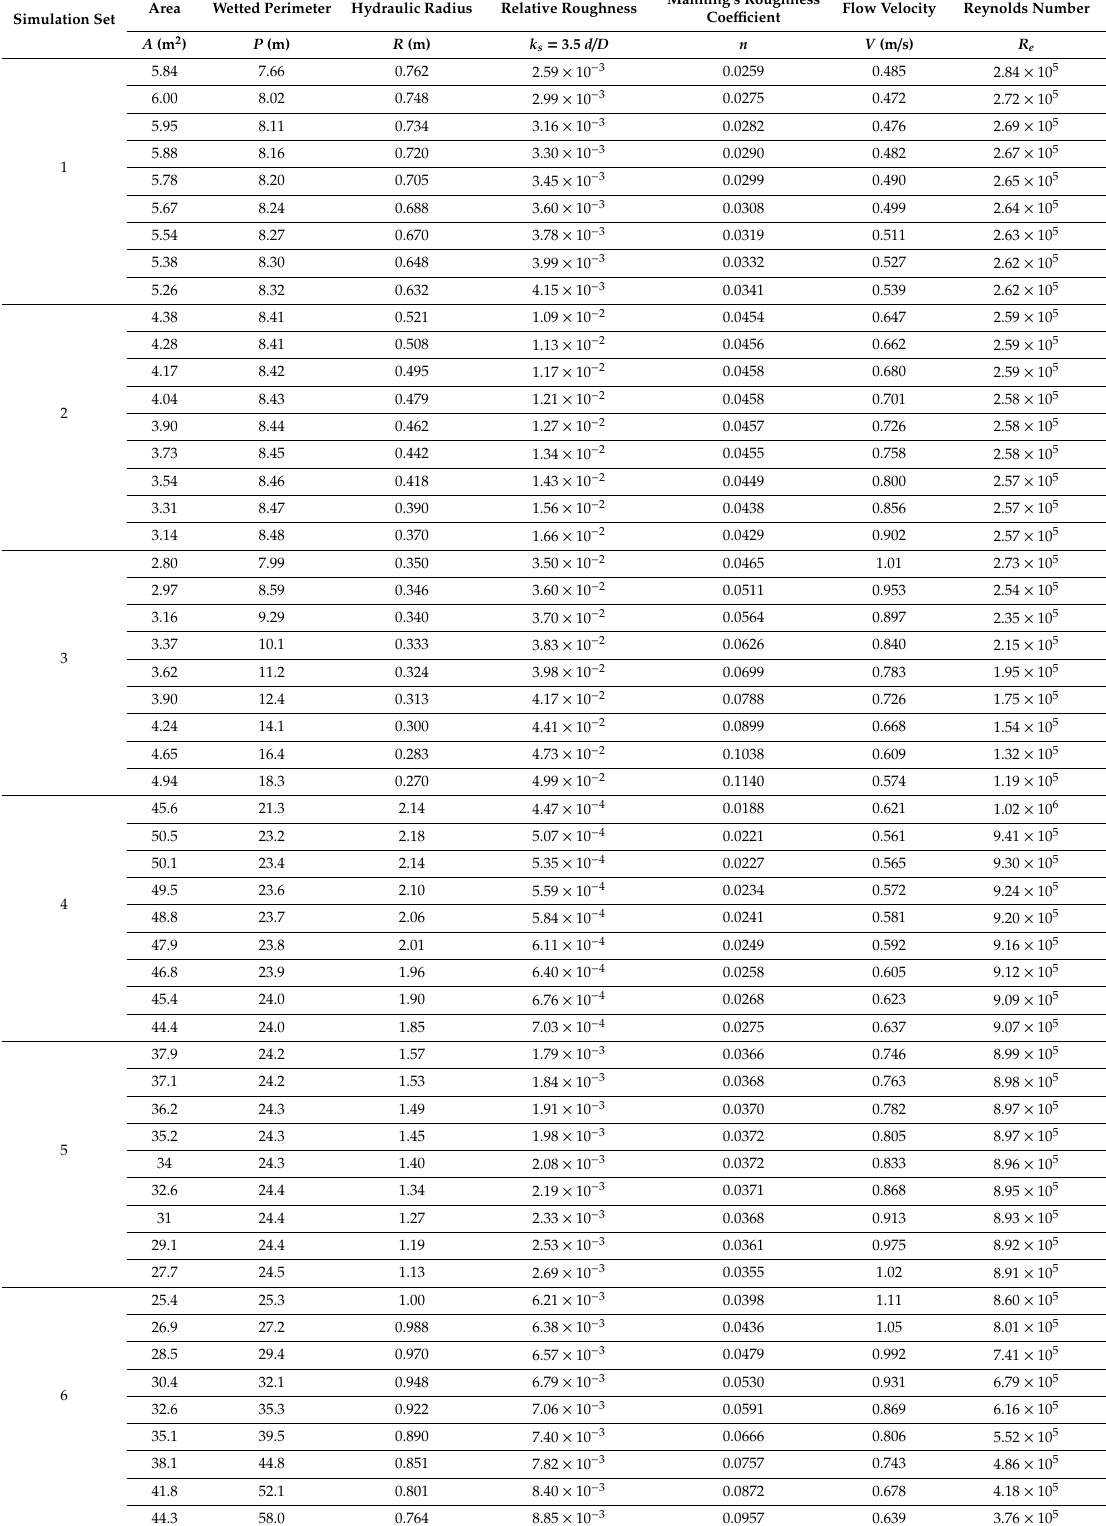
Table A2. Hydraulic properties of synthetic channels for each of twelve simulation sets. Simulation